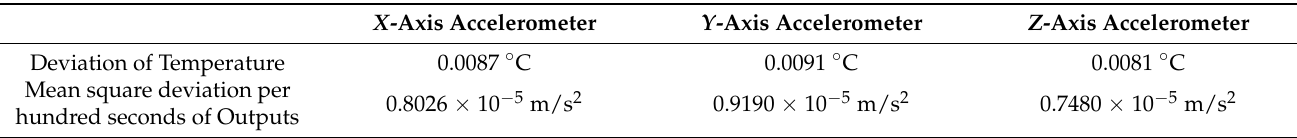
Table 6. The deviation of accelerometer temperature and mean square deviation per hundred seconds of accelerometer outputs in temperature control incubator test.